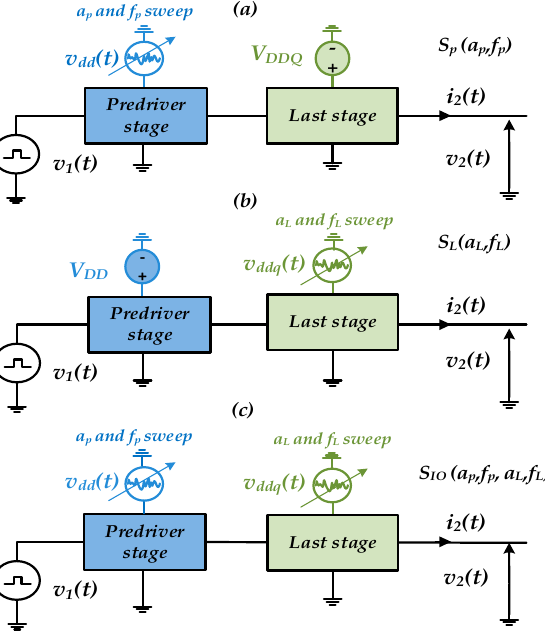
Figure 8. Frequency and amplitude-dependent PSIJ TF characterization ( a ) of pre-driver stage, ( b ) of last stage, ( c ) of driver’s IO stages.